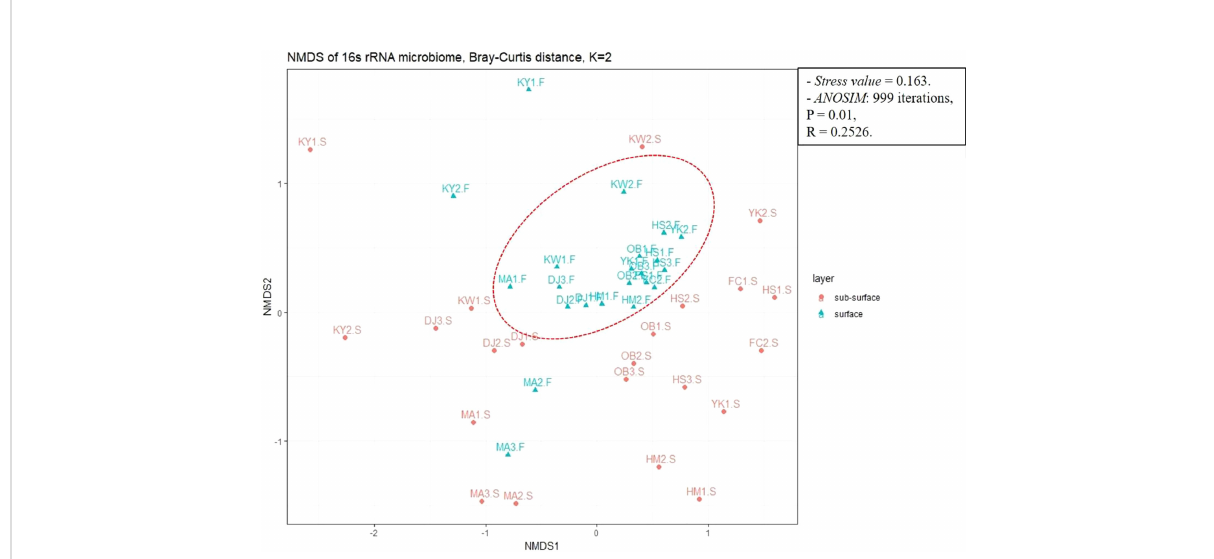
FIGURE 9 Beta diversity analysis showing the dissimilarity or distances between surface and sub-surface sites using non-metric dimensional scaling (nMDS) based on Bray-Curtis distance with stress value < 0.2 (0.163). Analysis of similarity (ANOSIM) was calculated to con fi rm the signi fi cant difference in microbiota community structure between sediment groups (p <